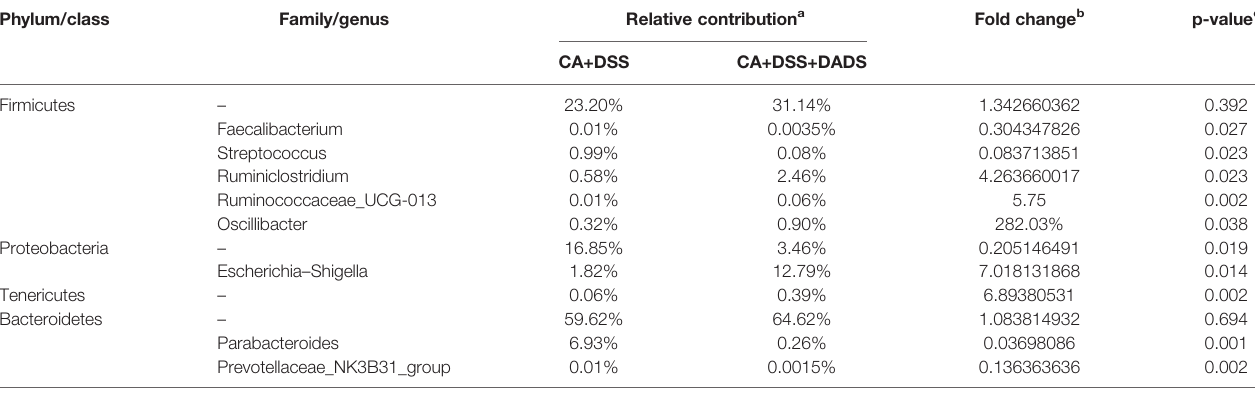
TABLE 2 | Changes of gut microbiota at different levels among the two